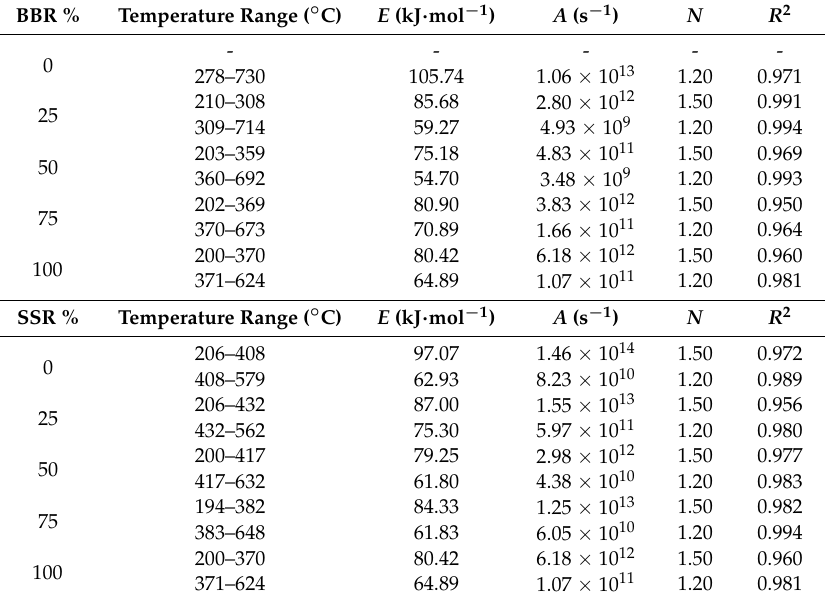
Table 4. Kinetic parameters for various sludge-coal ratios and sludge-shiitake ratios calculated using Coats-Redfern method (BBR = SSR = 100%: pure